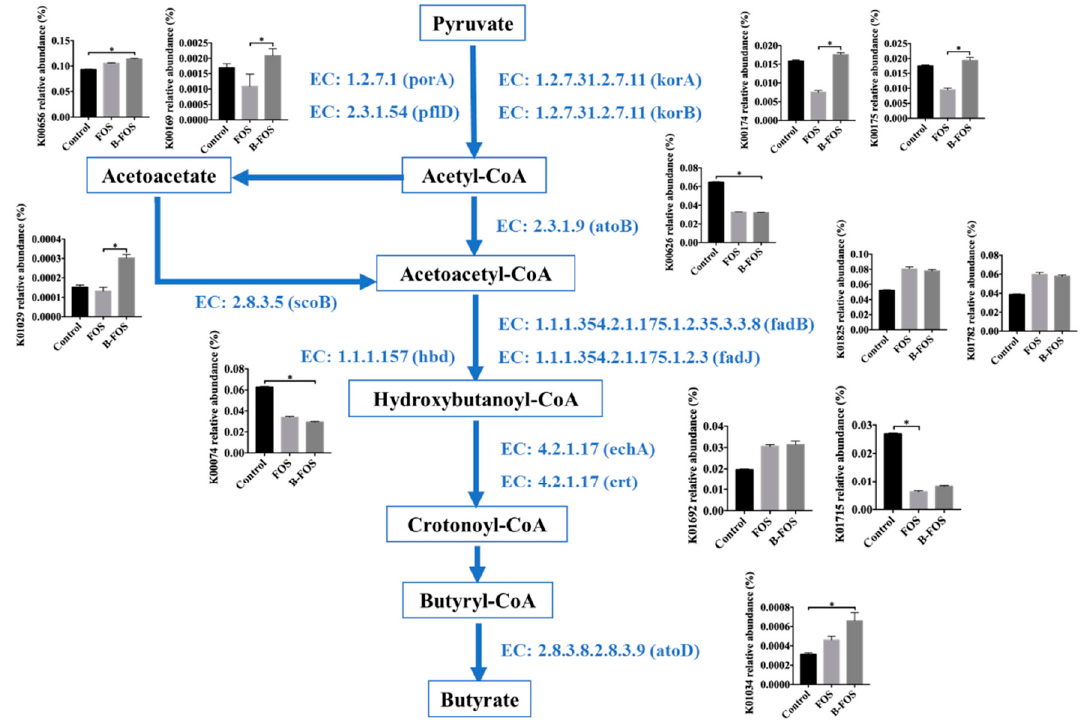
Figure 7. The butyrate production pathway in commensal butyrate-producing bacteria. Related enzymes involved 2-oxoacid ferredoxin oxidoreductase subunit alpha (korA), 2-oxoacid ferredoxin oxidoreductase subunit beta (korB), pyruvate ferredoxin oxidoreductase alpha subunit (porA), formate C-acetyltransferase (pflD), acetyl-CoA C-acetyltransferase (atoB), 3-hydroxyacyl-CoA dehydrogenase (fadB), 3-hydroxyacyl-CoA dehydrogenase (fadJ), 3-hydroxybutyryl-CoA dehydrogenase (hbd), enoyl-CoA hydratase (echA), enoyl-CoA hydratase (crt), acetate CoA/acetoacetate CoA-transferase alpha subunit (atoD), 3-oxoacid CoA-transferase subunit B (scoB). Arrows indicate the related genes that are involved in the corresponding pathway. Error bars represent means ± SD of triplicate cultures. Significance was accepted at * p < 0.05 ( n = 3).